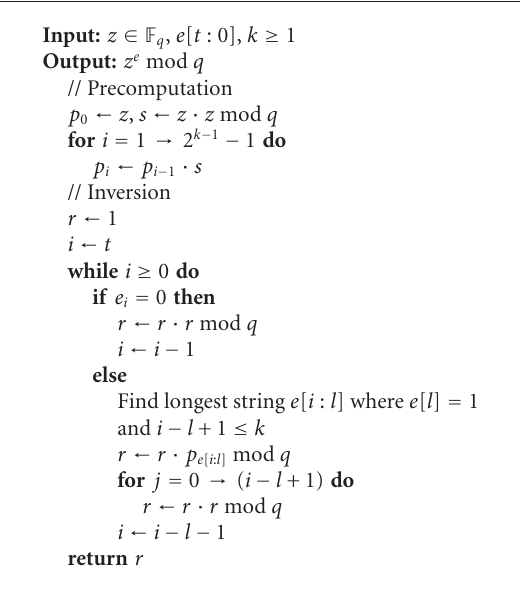
Algorithm 2: Sliding window modular exponentiation [24].